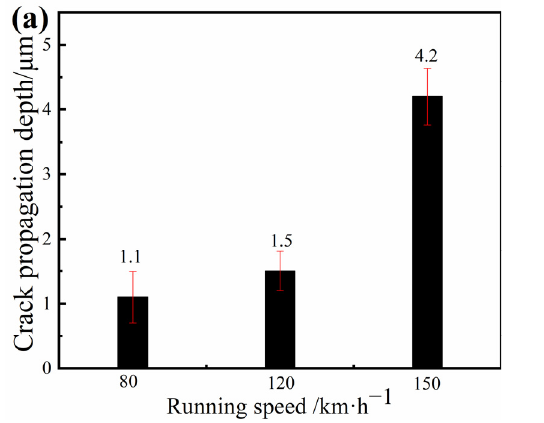
Figure 13. Curves of ( a ) the crack propagation depth and ( b ) the crack propagation angle with running speeds.